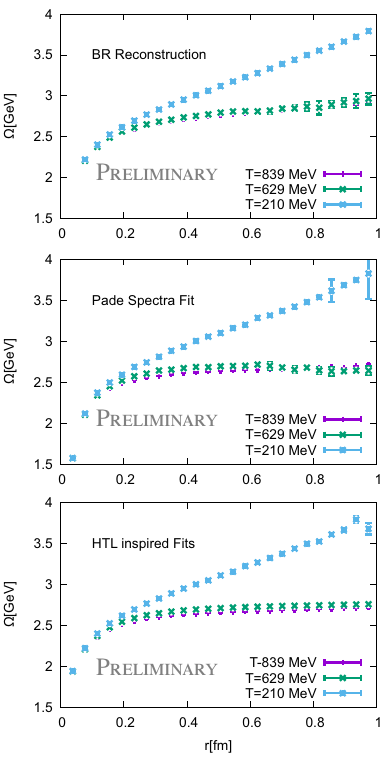
Figure 3. Extracted values of the position of the dominant spectral peak Ω on quenched anisotropic lattices using the BR method (top), the Padé approach (middle) and the HTL inspired fit (bottom). The results from the confined phase at T = 210MeV are shown as light blue crosses, two results from the deconfined phase at T = 629MeV and T = 839MeV as green and violet data points